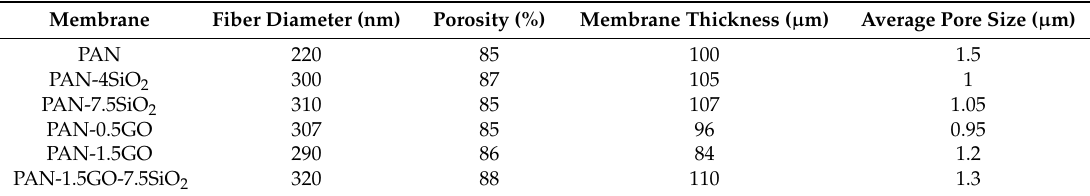
Table 2. Characteristics of the developed membranes.